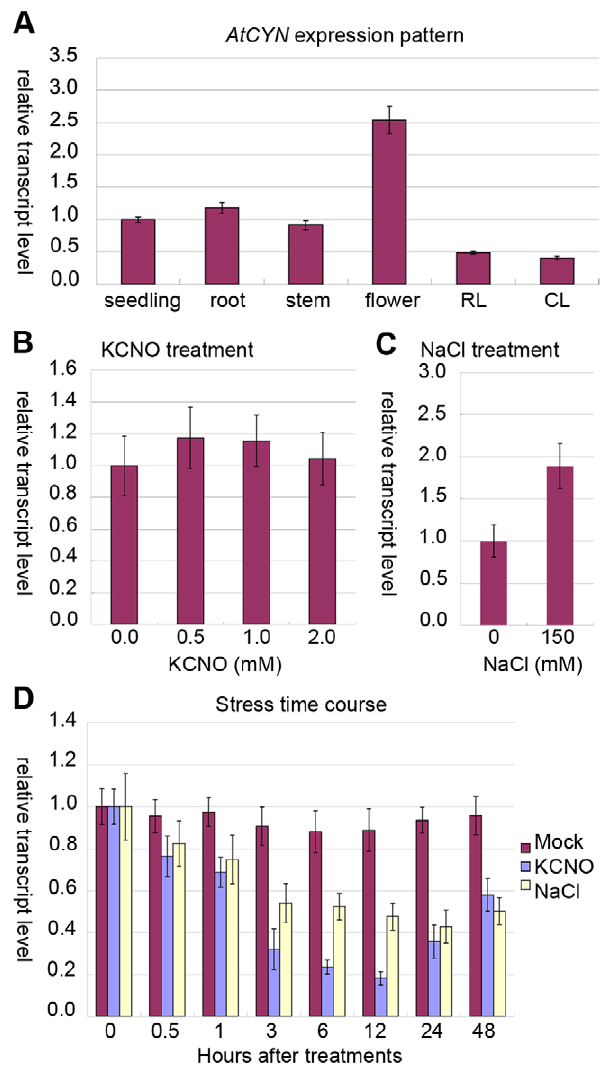
Figure 9. Quantitative RT-PCR analysis of AtCYN transcription. (A) The AtCYN transcript levels in different plant organs. RL (rosette leaves), CL (cauline leaves); (B) and (C) Samples are the 7-day-old seedlings which grew in the MS medium containing KCNO or NaCl. The AtCYN transcript levels in response to treatment with three KCNO concentrations (B) and in response to treatment with 150 mM NaCl (C); (D) The 7-day-old seedlings from the standard MS medium were transferred to the MS medium containing 1 mM KCNO or 150 mM NaCl, and the samples were harvested at different time points. Error bars represent the standard deviation of three biological replicates.